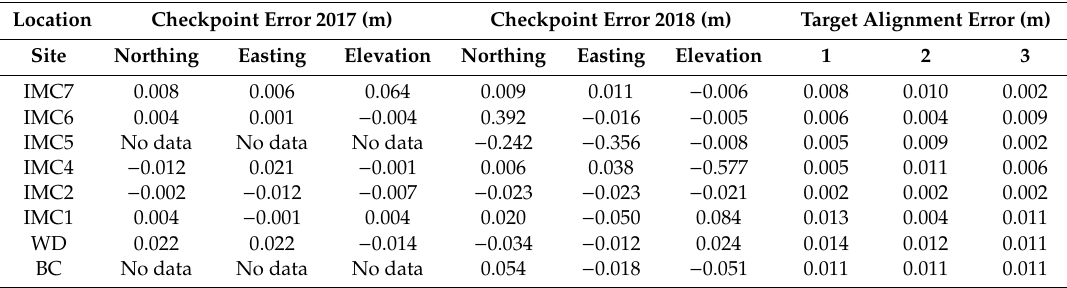
Table 3. End checkpoint error data from the total station surveys showing how much the instrument erred between the beginning and end of a streambank survey, along with alignment error from laser scanner targets in the Indian Mill Creek watershed 2017–2018. The IMC4 site was measured with only erosion pins so is not